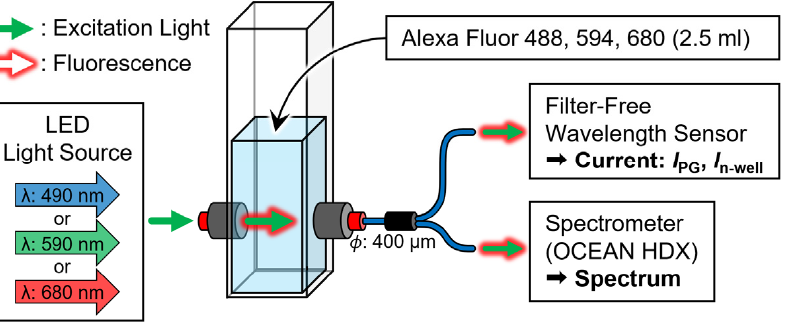
Figure 10. Schematic of an evaluation system to compare the current ratio of the sensor and spectral characteristics of the spectrometer for light emitted from a fluorescent reagent.